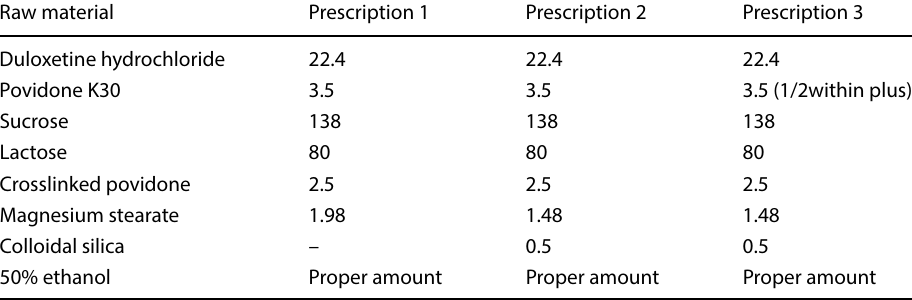
Table 1 Core composition (calculated as 1,000 tablets, unit: